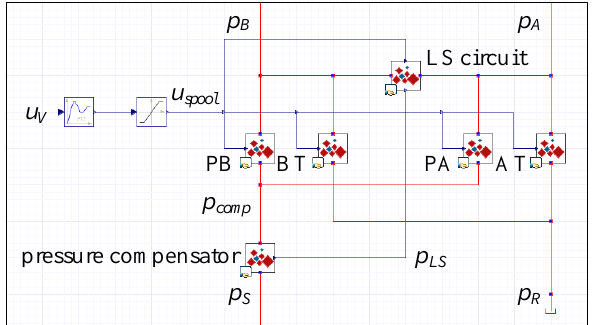
Figure 7: Structure of DCV